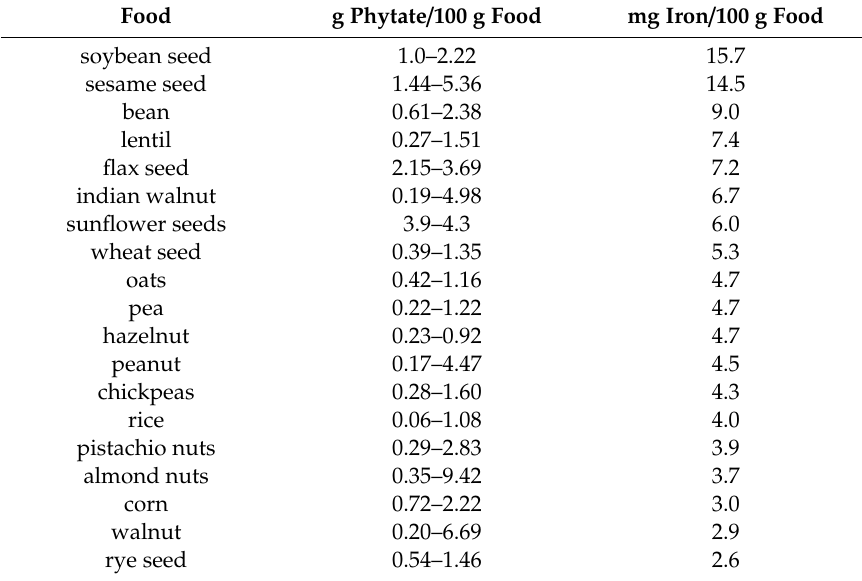
Table 3. Phytate and iron content in selected foods